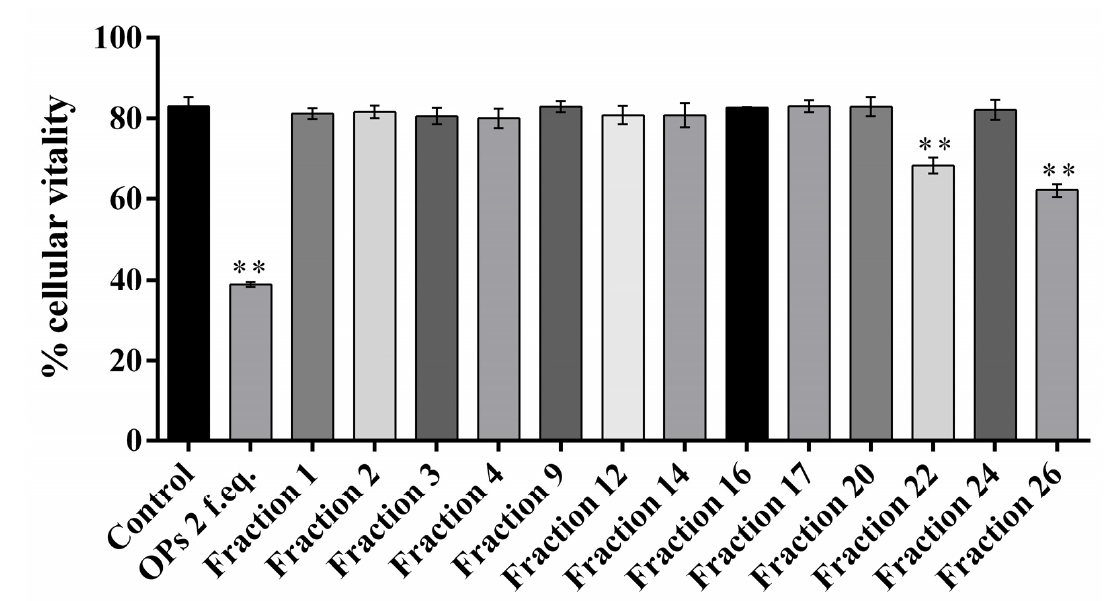
Figure 2. Percentage of vital hemocyte extracted from larvae incubated with 1× PBS (control), ovarian proteins (OPs), and HPLC fractions deriving from two equivalent females (2 f. eq.). Data are reported as means ± SD of n = 3 independent experiments. Statistical analysis was performed with unpaired t -test with Welch’s correction against control. The asterisk indicates significant differences ( p value < 0.0001).